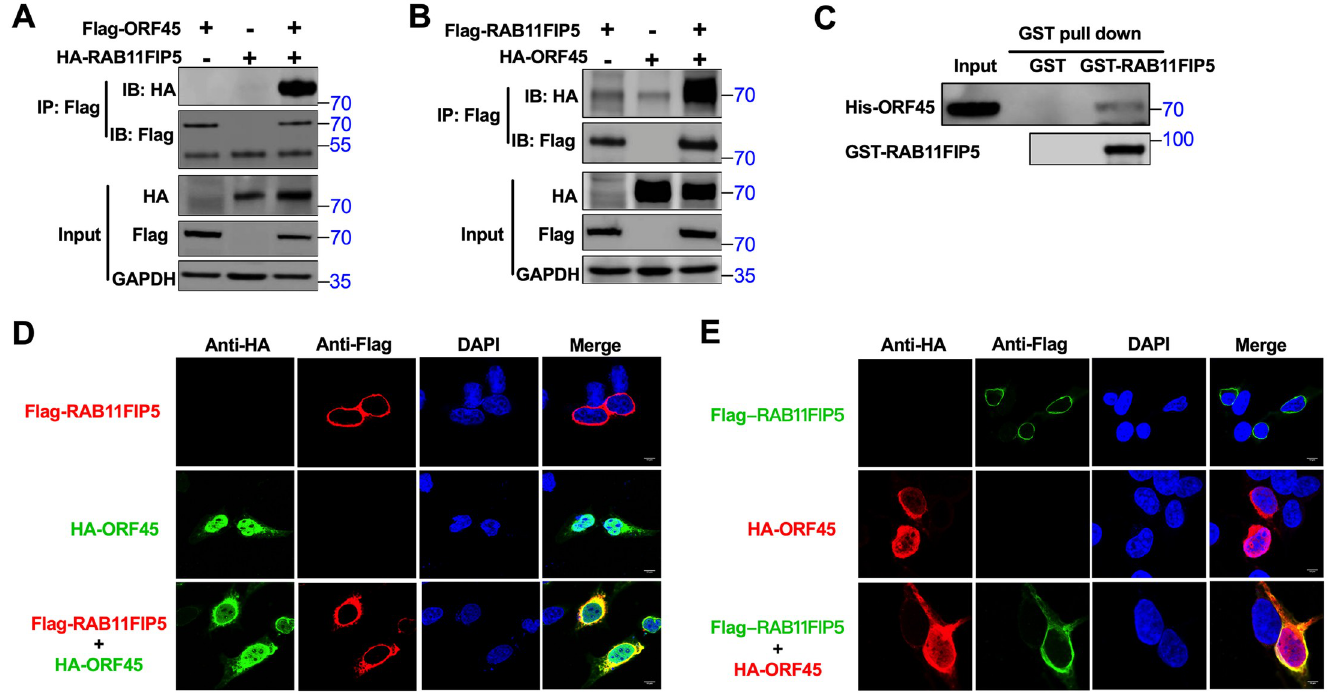
Fig 1. RAB11FIP5 interacts with KSHV ORF45. (A) HEK293T cells were transfected with Flag-ORF45 alone, with HA-RAB11FIP5 alone or with both Flag-ORF45 and HA-RAB11FIP5. Cell lysates were immunoprecipitated with an anti-Flag antibody and were then analyzed by western blotting with the indicated antibodies. (B) HEK293T cells were transfected with Flag-RAB11FIP5 alone, with HA-ORF45 alone or with both Flag-RAB11FIP5 and HA-ORF45. Cell lysates were immunoprecipitated with an anti-Flag antibody and were then analyzed by western blotting with the indicated antibodies. (C) In vitro GST affinity binding assay. Bacterially expressed GST and GST-RAB11FIP5 bound to GST-Sepharose beads were incubated with purified His-tagged ORF45, and the pulled down lysates were immunoblotted with anti-His or anti-GST antibodies. Colocalization of RAB11FIP5 and ORF45 in HeLa cells (D) and HEK293T cells (E). After transfection with Flag- RAB11FIP5 and HA-ORF45, HeLa cells and HEK293T cells were fixed with 4% paraformaldehyde and were then labeled with anti-HA and anti-Flag antibodies. FITC- and Cy3-conjugated secondary antibodies were used to visualize the labeled RAB11FIP5 and ORF45 proteins, respectively. DAPI was used to label cell nuclei.